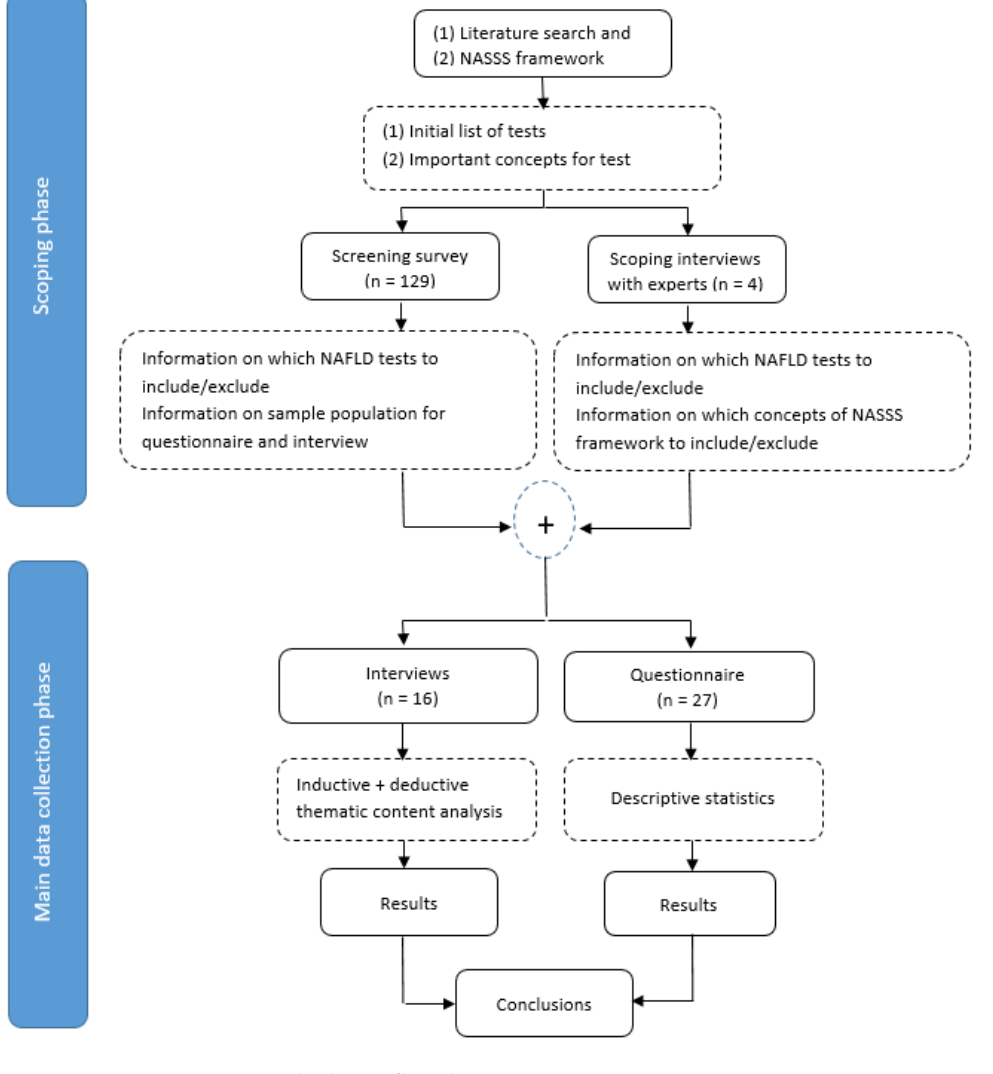
Figure 2. Study design flow diagram.